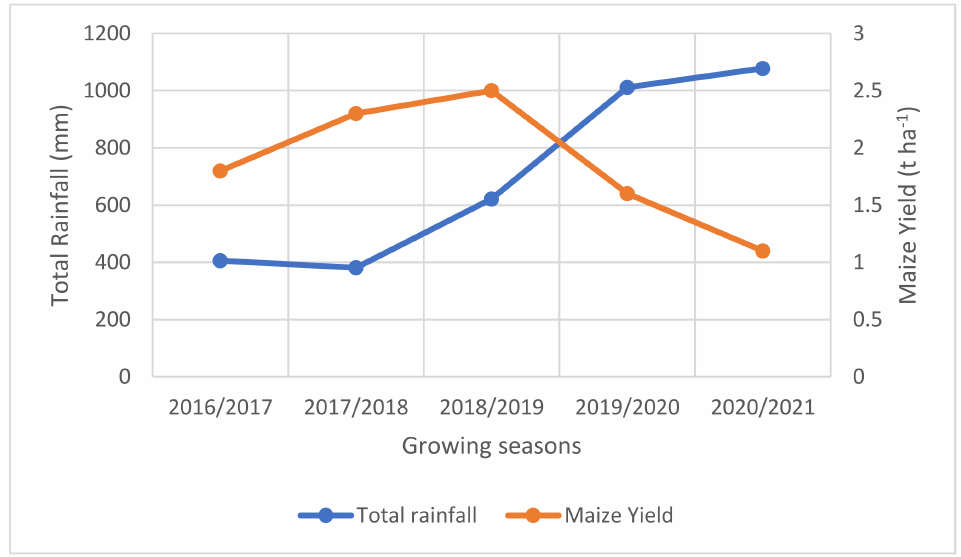
Figure 6. Relationships between total rainfall and maize yields during 2016/2017 to 2020/2021 growing seasons. Blue: total rainfall. Source: Weather and Climate [34]; Yellow: maize yield. Source: own data gathered from survey during the